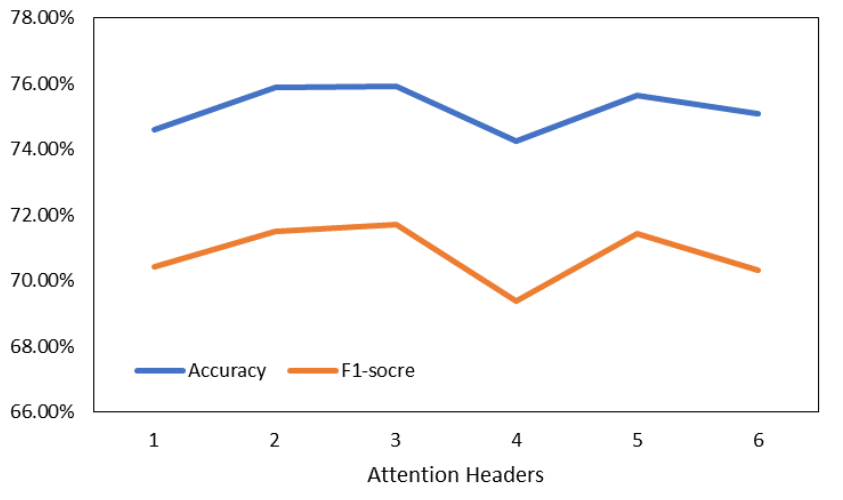
Figure 3. Impact of number of heads in MHA.